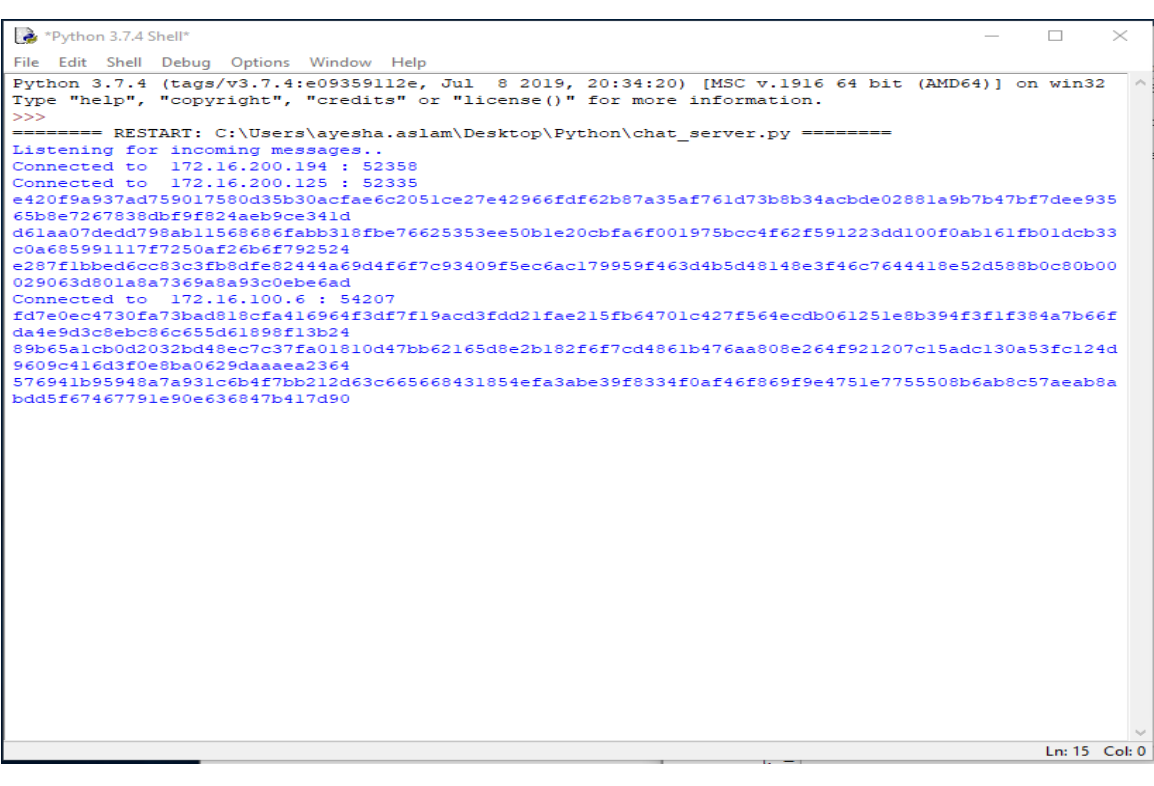
Figure 5. Hash for every record.